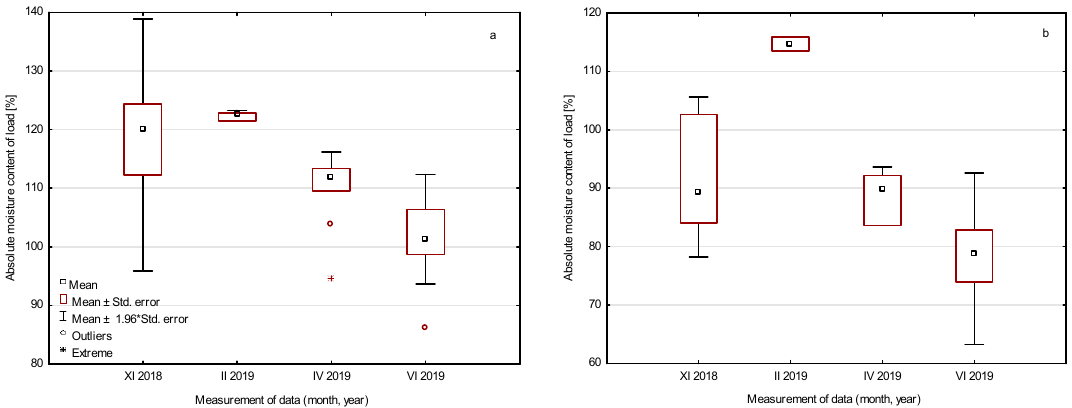
Figure 11. Absolute moisture content of load values by measurement date for wood chips ( a ); sawdust ( b ).